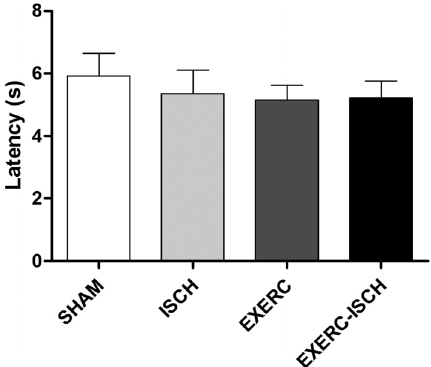
Figure 3. Transient global ischemia-reperfusion did not alter pain sensitivity measured by the tail- fl ick test. Data are reported as means ± SD for n=10 rats/group. SHAM: rats submitted to surgery without arterial occlusion; ISCH: rats submitted to ischemia-reperfusion surgery; EXERC: rats submitted to physical exercise before surgery without arterial occlusion; EXERC-ISCH: rats submitted to physical exercise before ischemia-reperfusion